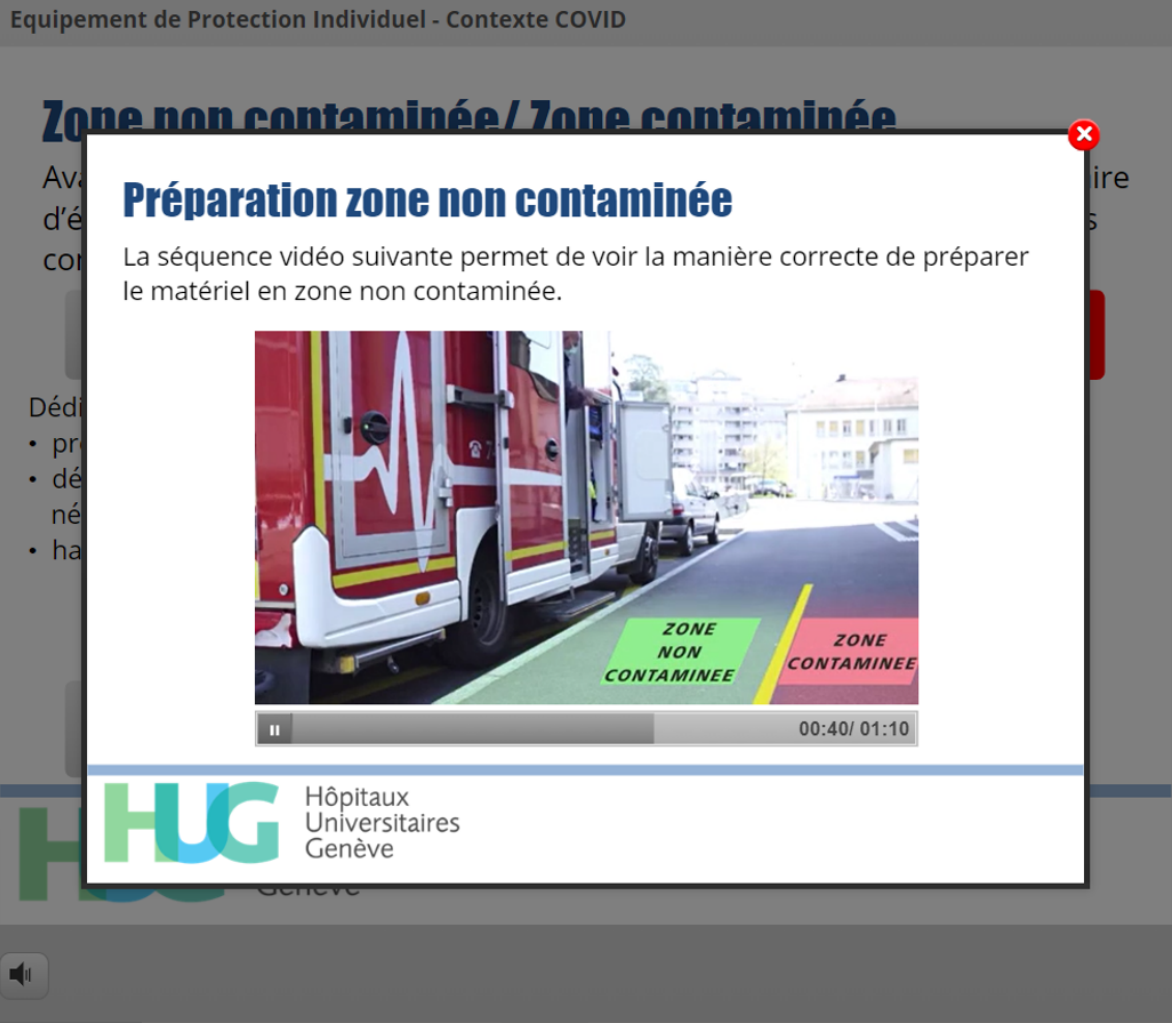
Figure 8. Use of embedded videos to display virtual zones. The learner has clicked on the Vidéo zone non contaminée (Uncontaminated Zone Video) button, and the slide containing the video is